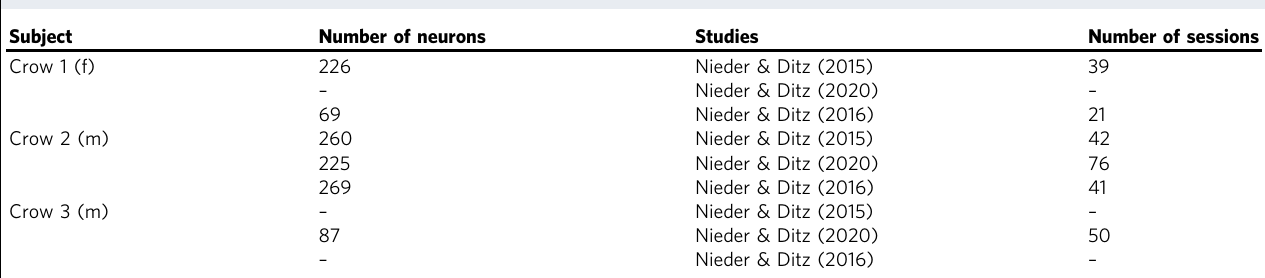
Table 1 Details on the data